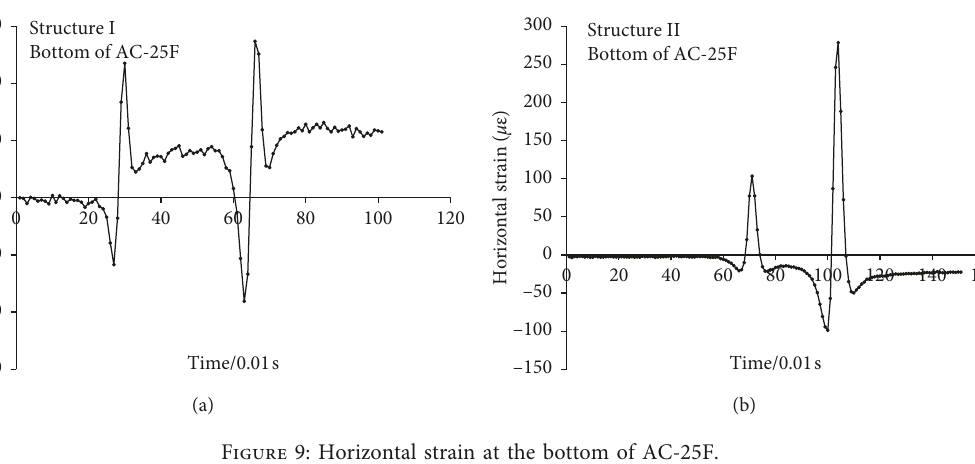
Figure 8: Horizontal strain at the bottom of AC-25C.